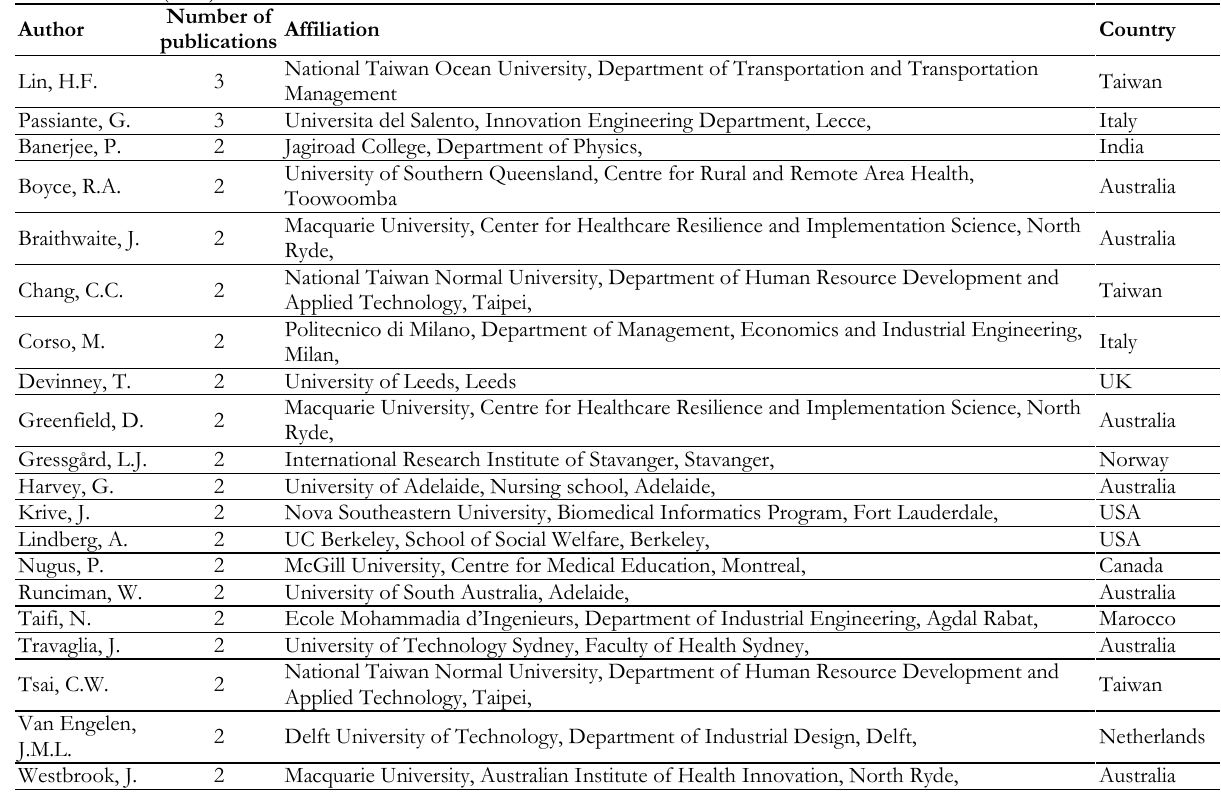
Table 1. Authors with the highest number of publications in the area, their affiliations and